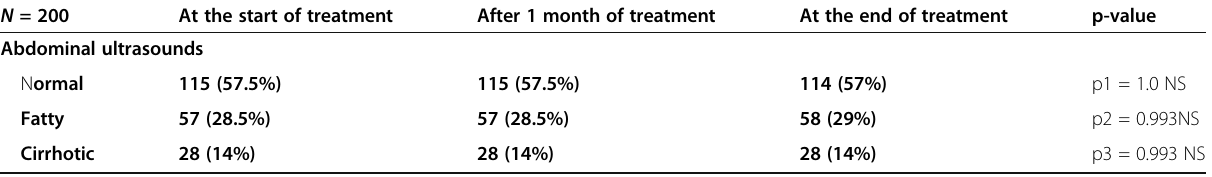
Table 4 Comparison between U/S results in the studied patients N = 200 At the start of treatment After 1 month of treatment At the end of treatment Abdominal